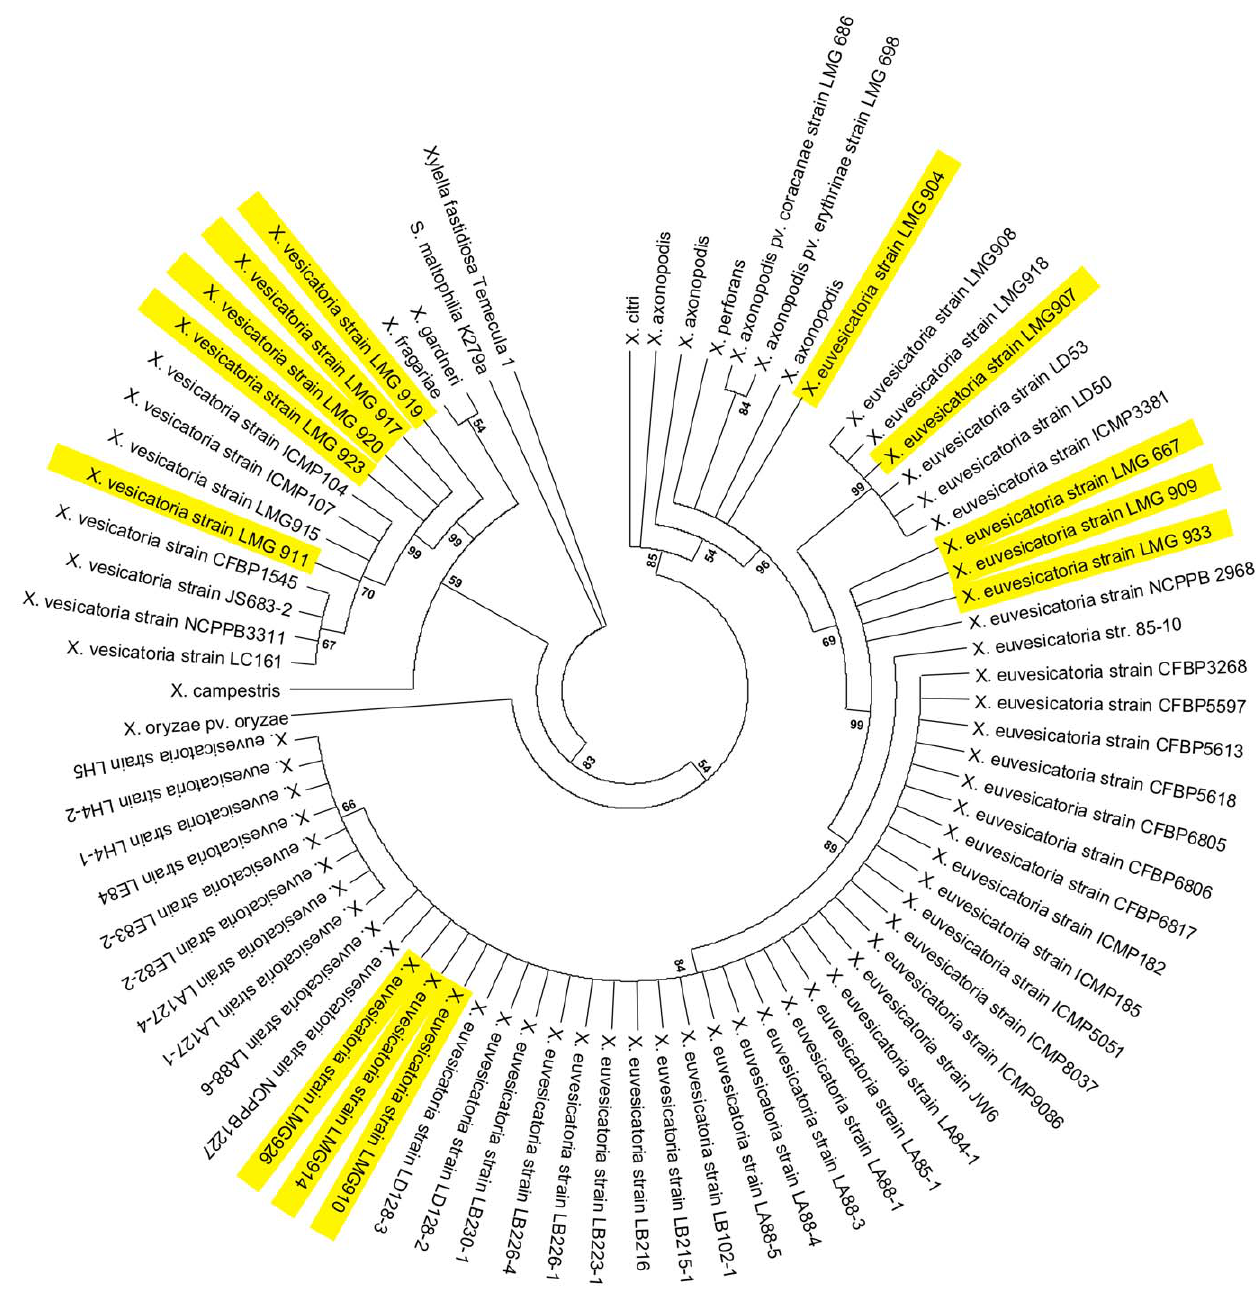
Figure 4. Neighbor-Joining Tree based on the concatenated sequences of four housekeeping genes of several Xanthomonas . The sequences of the housekeeping genes atpD , dnaK , efp and gyrB were concatenated and used to infer the MLST profile of X. euvesicatoria and X. vesicatoria strains used in this study, which are highlighted in yellow. The Neighbor-Joining tree was derived from the TN93 + G + I model and a bootstrap analysis of 1000 replicates.